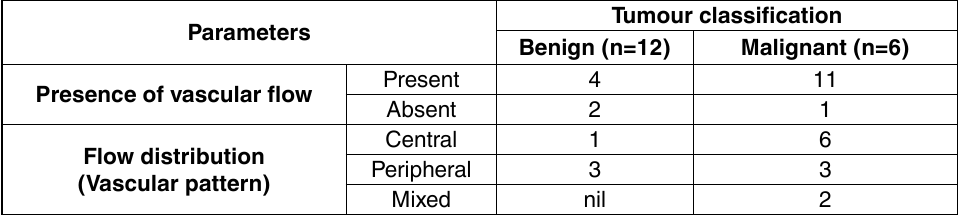
table 2. Parameters evaluated by Colour Doppler ultrasonography